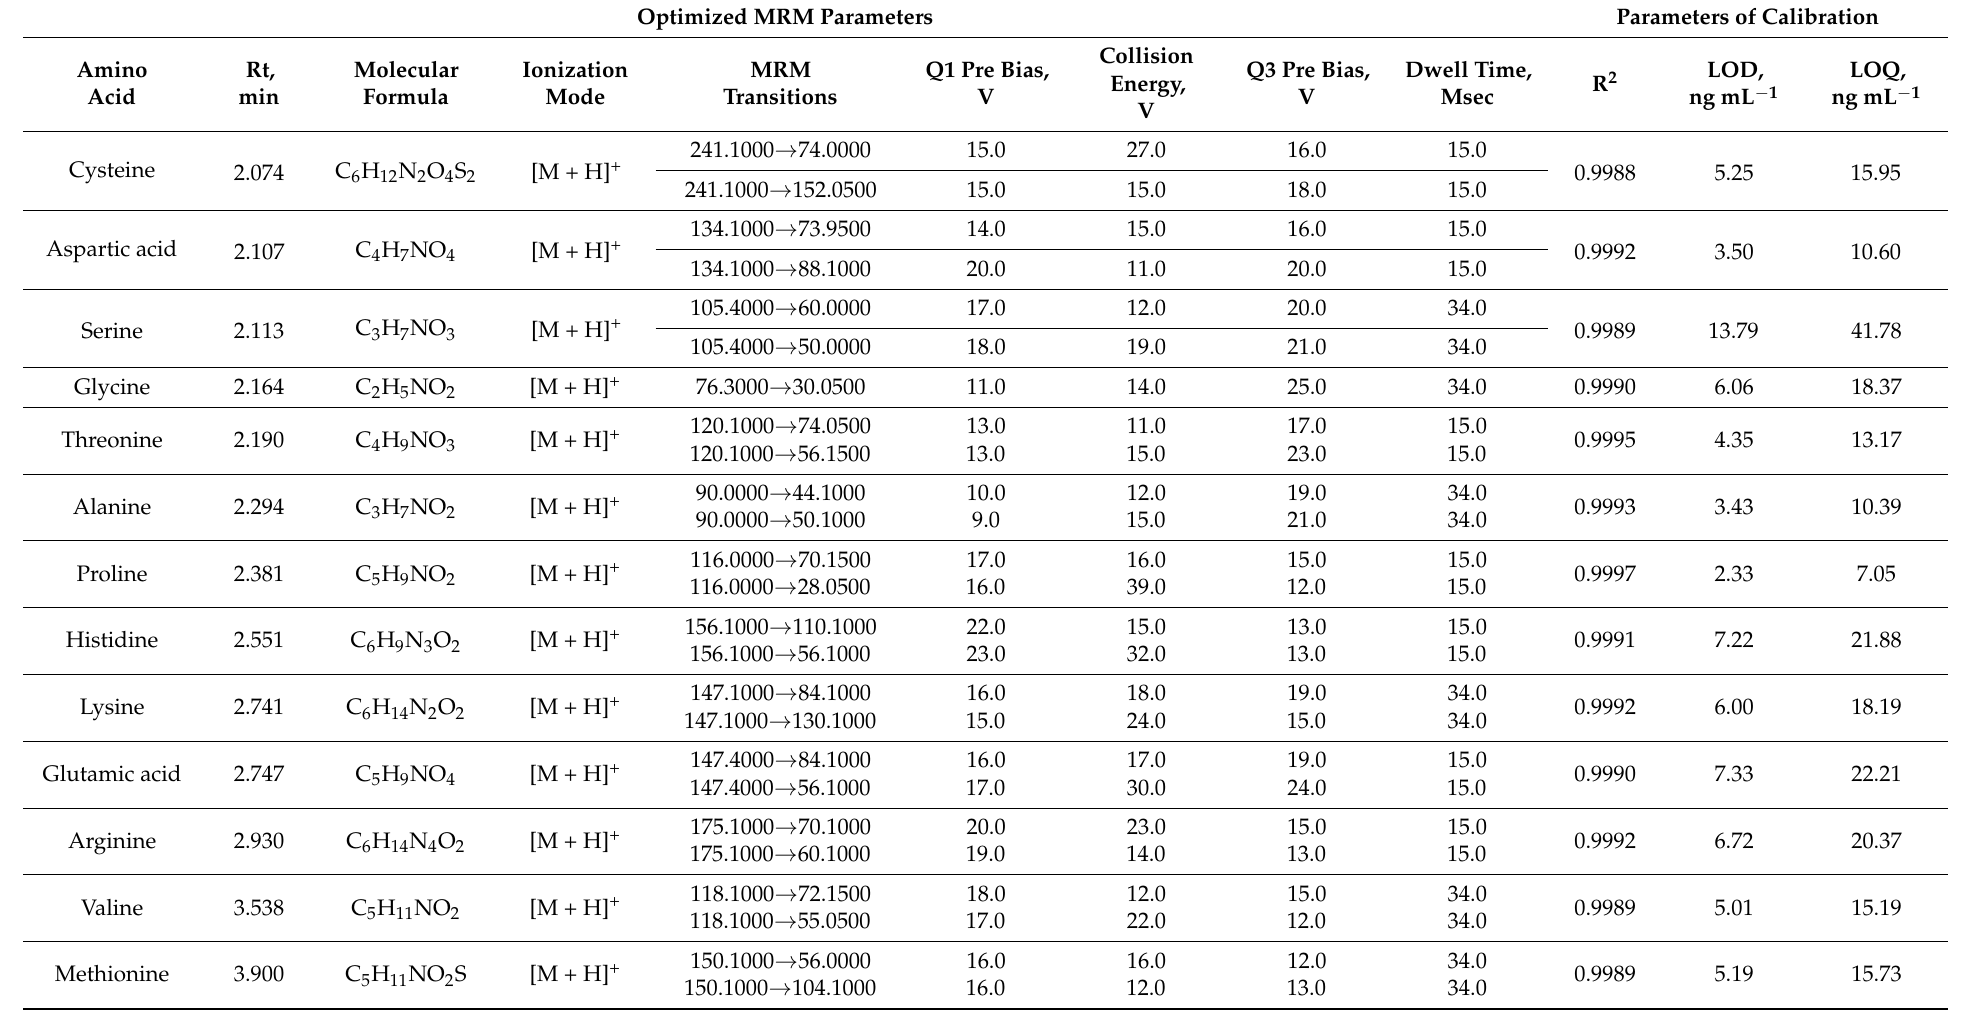
Table 2. The MRM transitions and corresponding collision energy, Q1, Q3 and dwell time for investigated amino acid